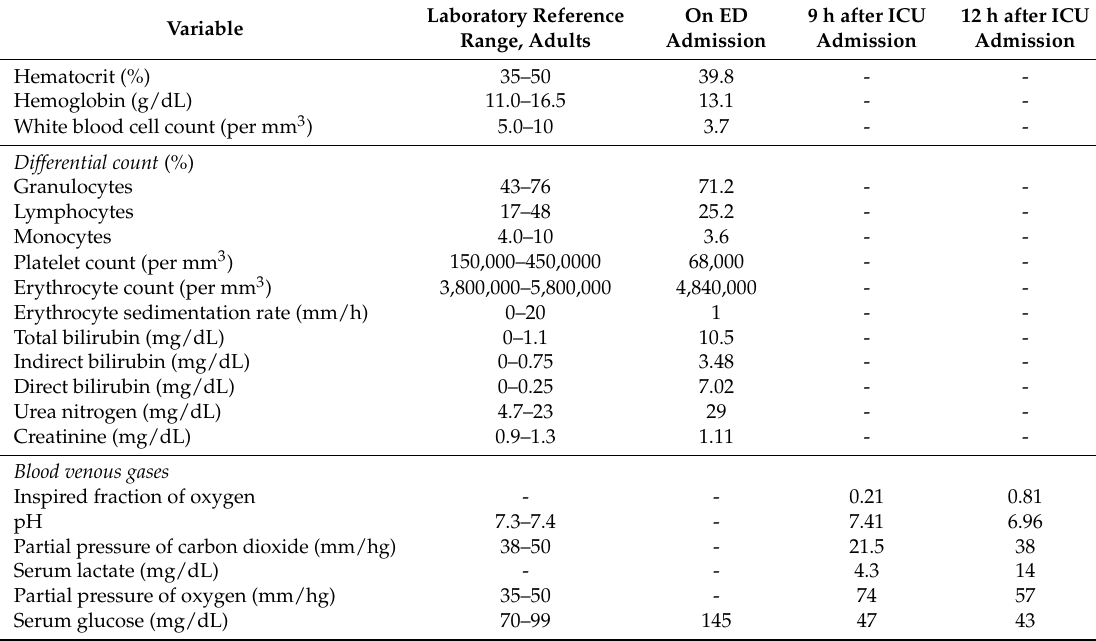
Table 1. Patient laboratory